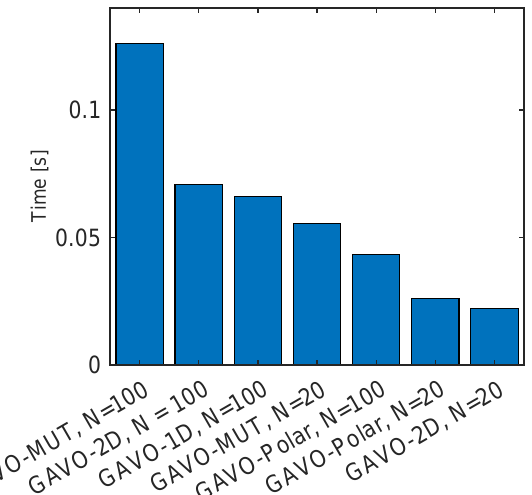
Figure 7. Comparison of the wall-clock time to the optimal solution for GAVO variants with different